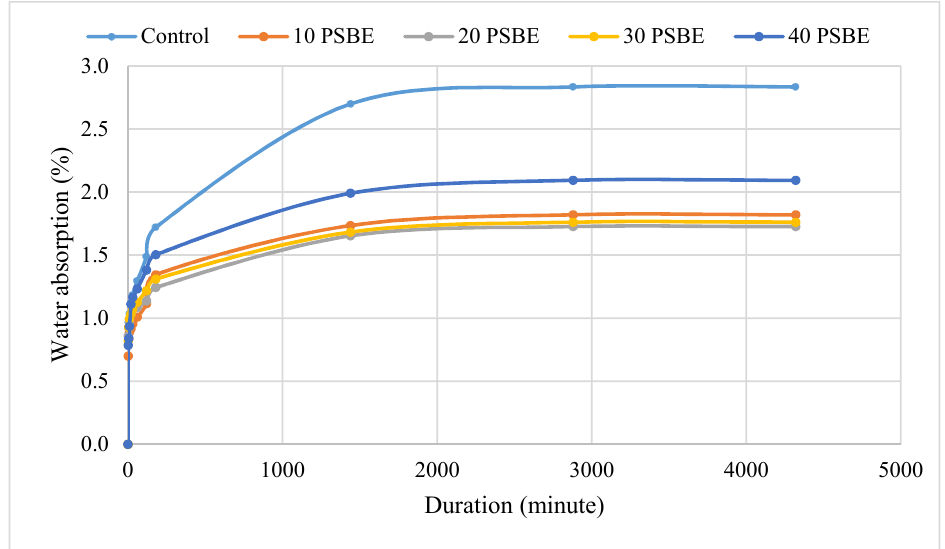
Figure 7. Water absorption of PSBE mortar.